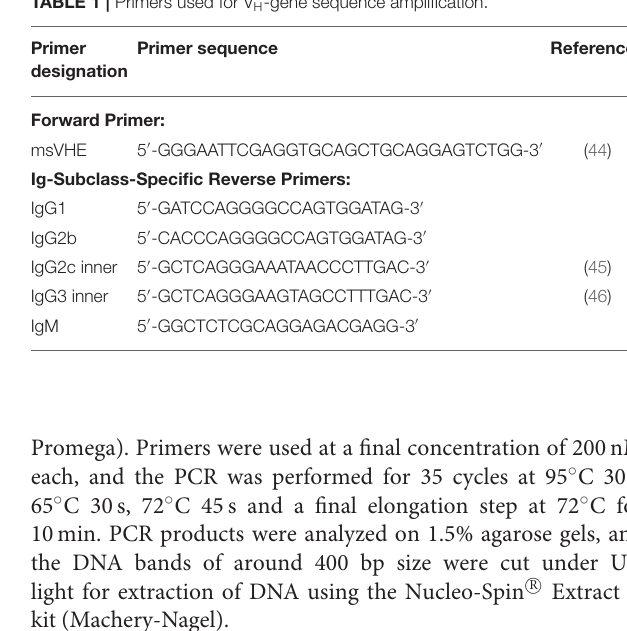
TABLE 1 | Primers used for V H -gene sequence